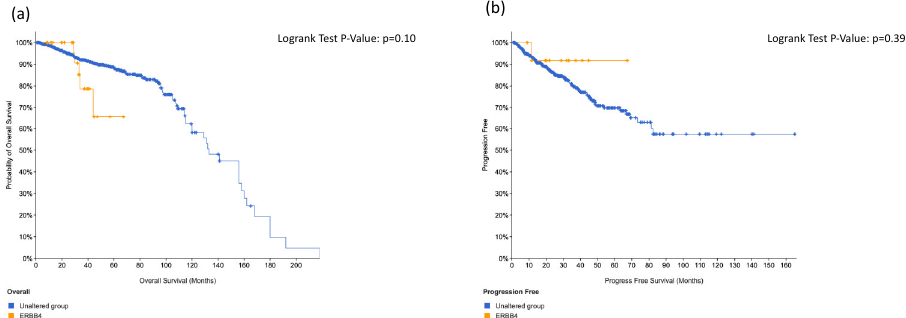
Figure 2. KIT , HRAS and CTNNB1 combination score prognosis in prostate cancer for overall sur- vival ( a ) and disease-free survival ( b ).